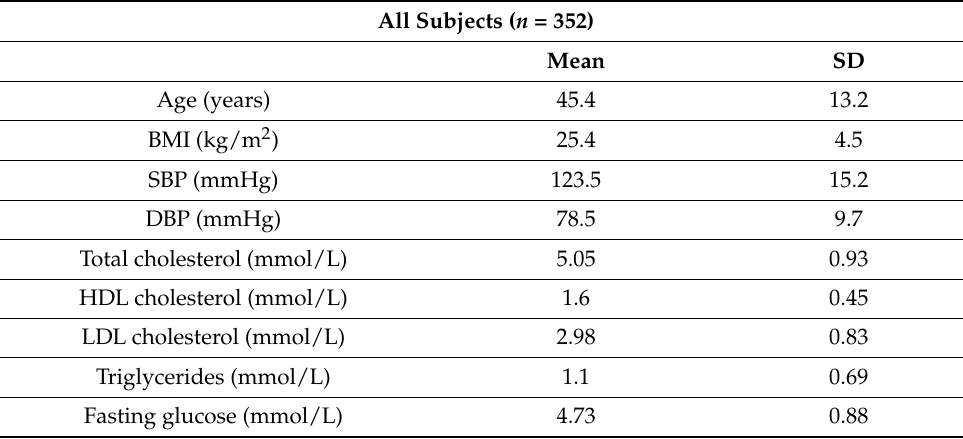
Table 2. Mean age, BMI and hematochemical parameters of all subjects. All Subjects ( n = 352)